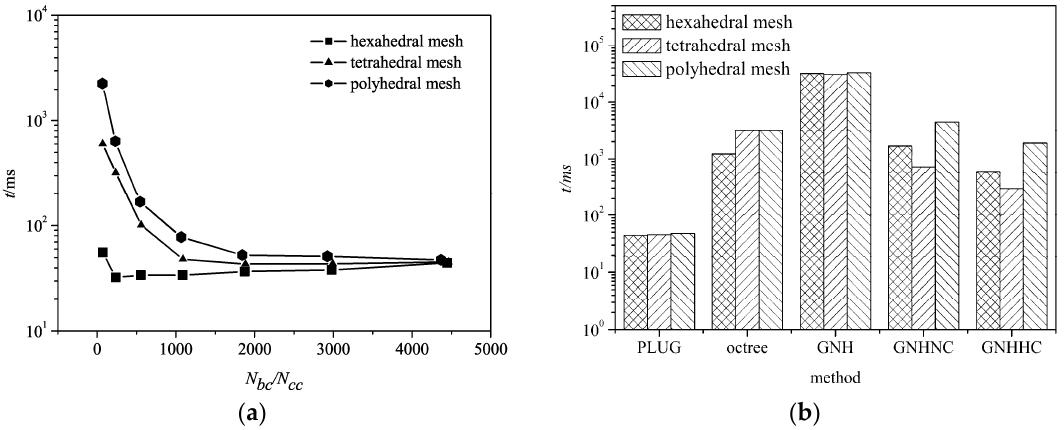
Figure 9. CPU times consumed by different particle-locating methods on different grids. ( a ) CPU times of PLUG method; ( b ) CPU times of other methods.